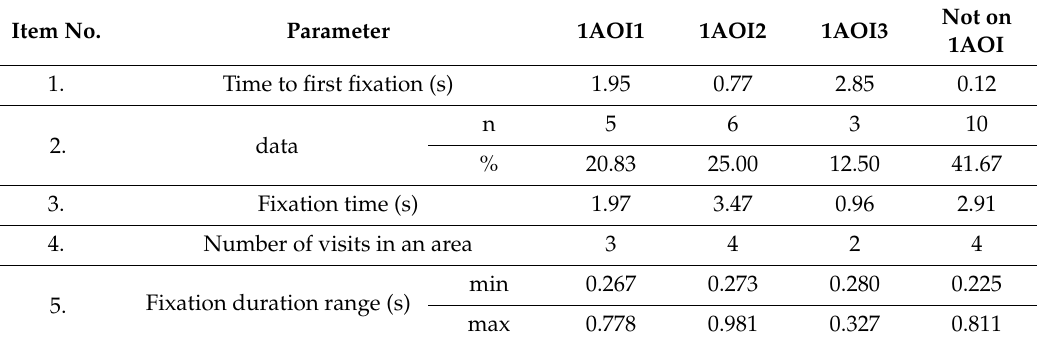
Table 2. Parameters characterising the gaze plot for one person relative to the areas outlined for analysis on image